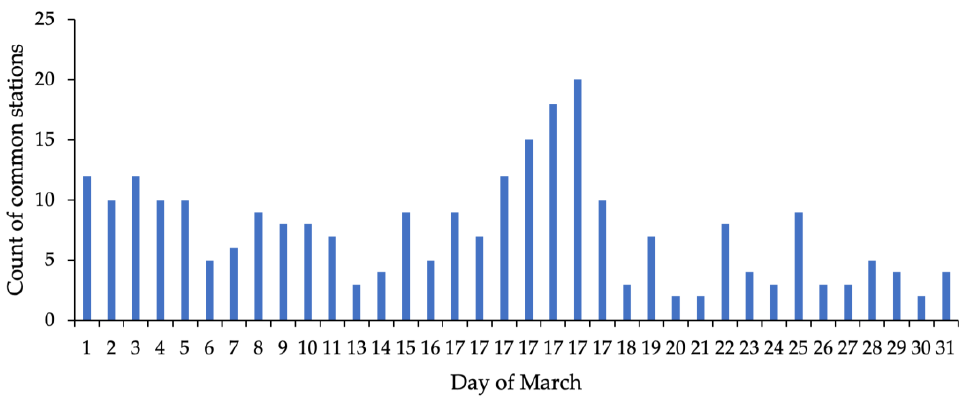
Figure 12. Count of common stations inside the five-cloud subsets intersection in each group ( 𝑃′ ). The mean values of the subsets of station coordinates were computed assuming a geometrical center of station sites in the whole peak subsets. The mean coordinates and other parameters are presented in Table 3 and Table S11. Table 3. Parameters of the peak cloud ( 𝑃 ) and five-cloud ( 𝑃′ ) center coordinates. Peak-Cloud Sets